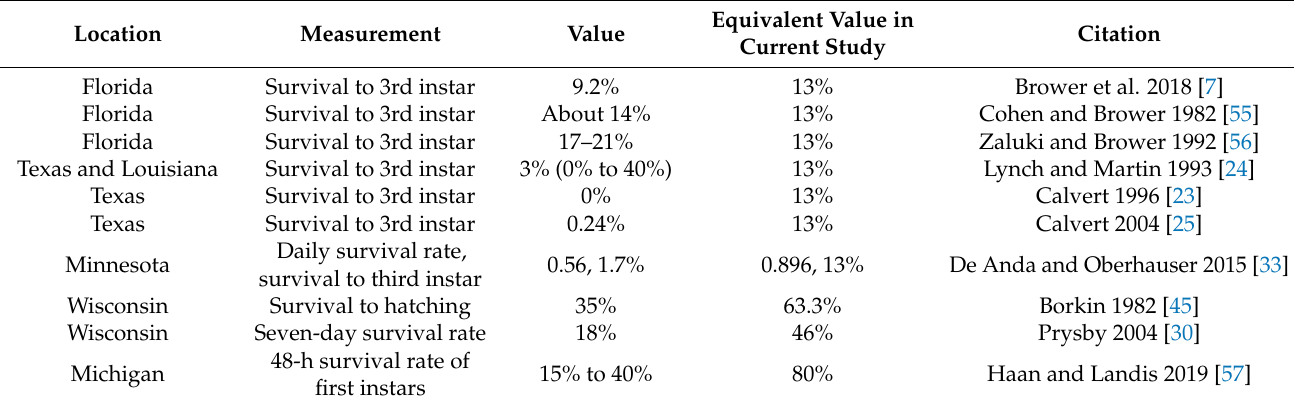
Table 4. Comparison of monarch survival measured in previous studies to the survival measured in the current study. All of these are field studies based on eggs and larvae that were not confined to enclosures and which were in outdoor settings presumably exposed to unmanipulated arthropod